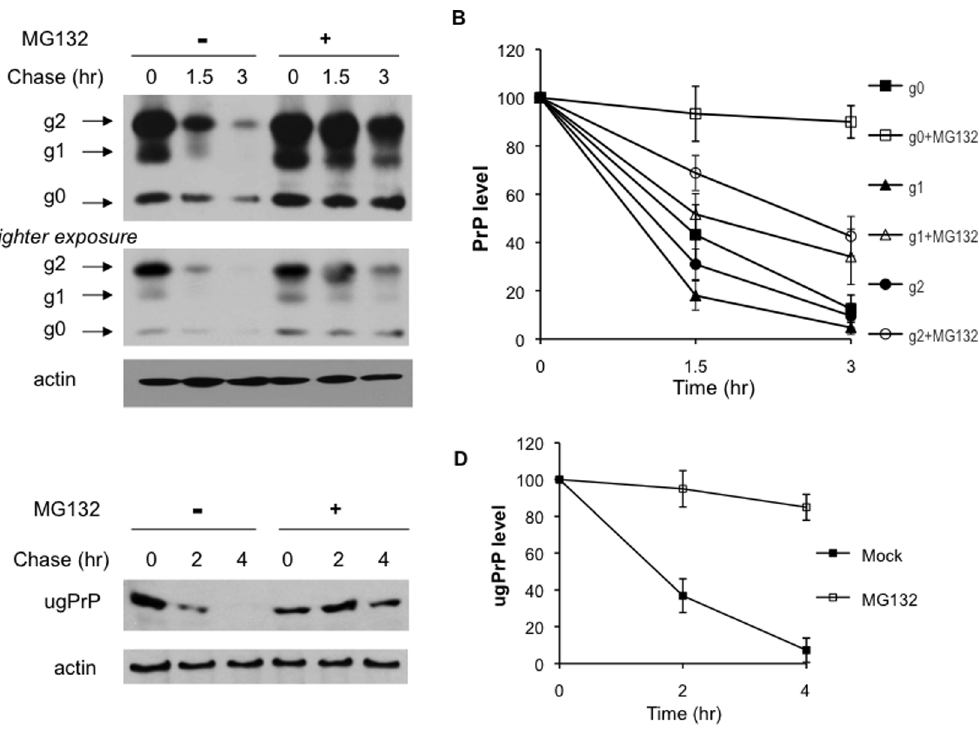
Figure 1. PrP degradation involves the proteasome. ( A ) PrP is degraded by the proteasome. HEK293 cells transfected with PrP were treated with or without the inhibitor of the proteasome MG132, cycloheximde was added to shut off protein synthesis and start the chase. Indicated times were taken and processed for immunoblotting with antibody recognizing PrP (3F4) or actin control. The arrows indicate PrP proteins attached with two (g2), one (g1) or no (g0) glycan. As some signals were saturated in the cycloheximide chase results presented (top panel), a lower exposure of the blot was included (middle panel). ( B ) Quantitation of the data in A. Three different glyco-forms of PrP were analyzed separately as indicated using ImageQuant software. We chose non-saturated bands for quantitation and normalized with the loading control actin. Whereas the bands for g1 species were quantified using the blot more heavily exposed (top panel), the g0 and g2 species were quantified with the lighter blot (middle panel). The experiments were done at least three times, and the average values with standard deviation are shown. ( C ) ugPrP turnover requires the proteasome. The plasmid expressing ugPrP (N181Q and N197Q) devoid of glycosylation was transfected into HEK293 cells. ugPrP stability in the presence or absence of MG132 was conducted as described in (A). ( D ) Quantitation of the data in C from 3 experiments.